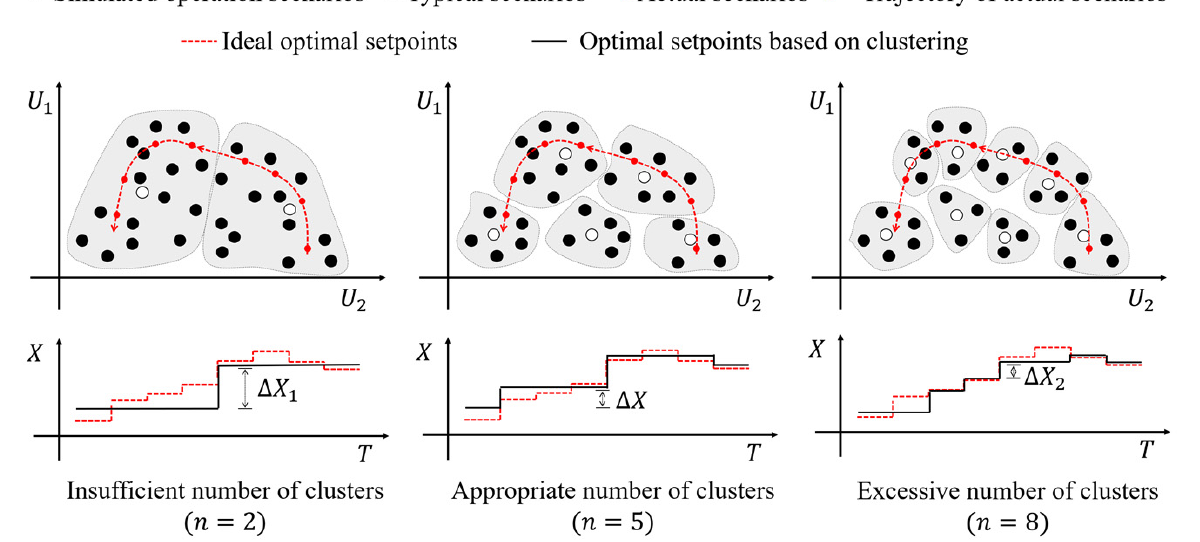
Figure 4. Optimal setpoints under di ff erent number of clusters.